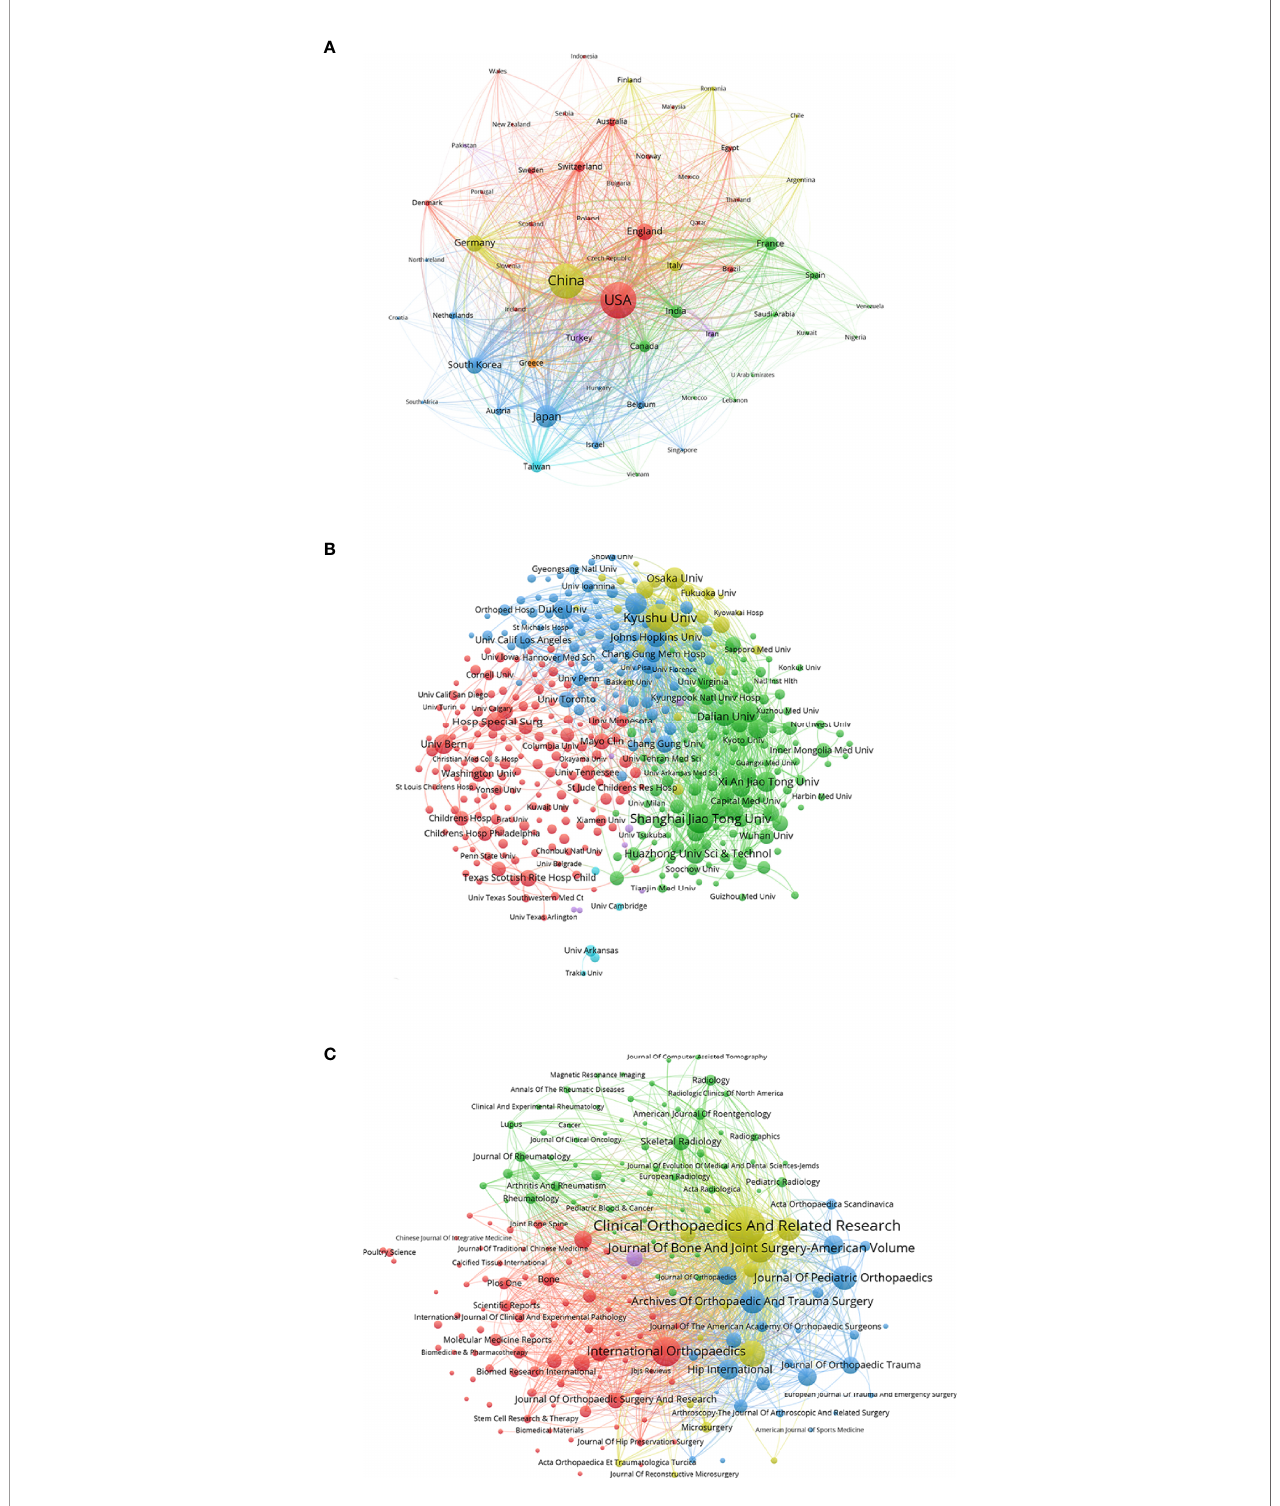
FIGURE 5 | Bibliographic coupling analysis of global publications in ONFH in the last 30 years. (A) Network visualization of the 59 identi fi ed countries in ONFH. (B) Network visualization of the 405 identi fi ed institutions in ONFH. (C) Network visualization of the 189 identi fi ed journals in ONFH. In the visualized network, each item is represented by a circle. The size of the circle is determined by the number of publications of the item. The distance between two circles approximately indicates the relatedness of the items. The color of an item is determined by the cluster to which the item